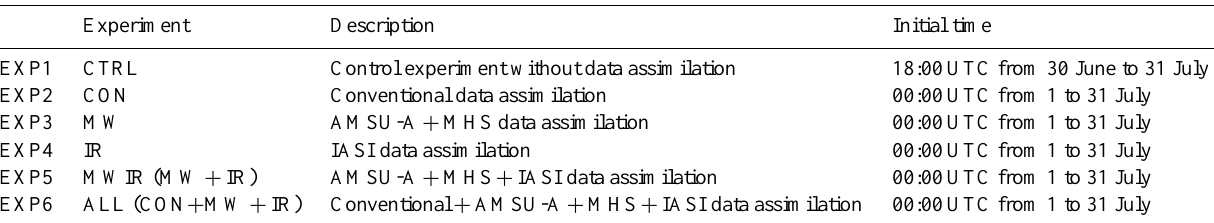
Table 1. The experiment design includes six simulations (EXP1–EXP6). All experiments are made from 30 June to 31 July 2012 and make a 72h forecast for each day.